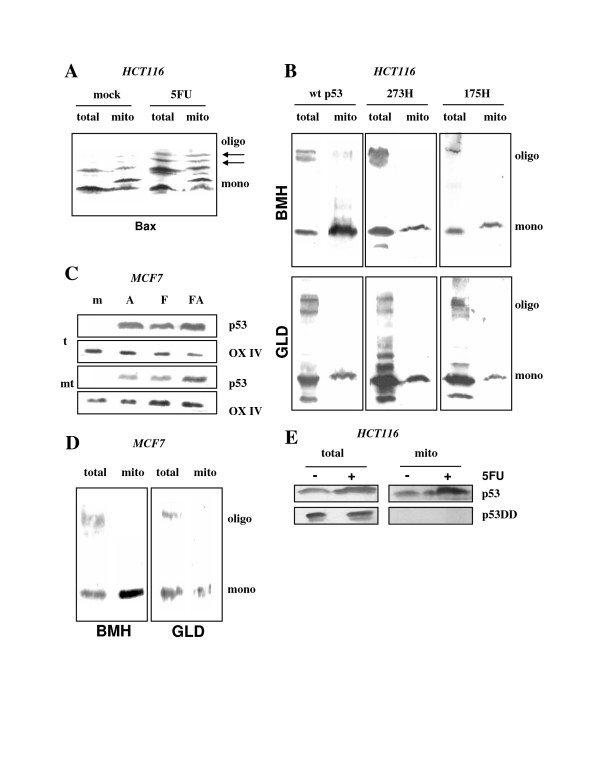
p53 monomers and oligomers in the cell and at the mitochondria. (A) HCT116 cells treated with the apoptosis-inducing drug 5FU (375 μM) for 24 h show more oligomers of the apoptotic BH123 protein Bax in the mitochondrial fraction. These were detected in a standard SDS-PAGE after chemical crosslinking with BMH and subsequent immunoblotting with anti-Bax antibody sc-493 at 1:500 dilution (See Materials and methods for details). Total: total cell extract; mito: mitochondrial fraction. Oligo: oligomers; mono: monomers. (B) Analogous study of p53 oligomerization in the indicated cell lines and after treatment with 5FU. BMH: bis-maleimidohexane; GLD: glutaraldehyde. Again, oligomers were detected in a standard SDS-PAGE; the anti-p53 antibody was DO-1 (1:2000). wt p53: HCT116 cells infected with vector-only. 273H, 175H: HCT116 p53-/- cells infected with a retroviral vector producing either mutant 273H or 175H. (C) Wt p53 in MCF-7 cells translocates to the mitochondria upon treatment with α-amanitin (10 μM; A), 5FU (375 μM; F), or both combined (FA). Cultures were mock-treated or treated as indicated for 24 h, and were then fractionated as described in Materials and methods. 15 μg of total protein (t) or mitochondrial protein (mt) were subjected to Western immunoblot analysis with either anti-p53 antibody DO-1 (1:2000) or anti-cytochrome oxidase IV (OX IV) antibody (1:1000). (D) In analogy to (a) and (b), MCF-7 cells were treated with 5FU for 24 h, and p53 oligomerization in the cells and in the mitochondrial fraction was monitored by standard SDS-PAGE and immunoblotting after BMH or GLD crosslinking. p53 was detected with antibody DO-1 (1:2000). (E) Mutant p53DD does not translocate to the mitochondria. In HCT116 cells retrovirally infected to express p53DD, endogenous wt p53 is stabilized and mitochondria-associated upon 5FU treatment whereas p53DD is not.